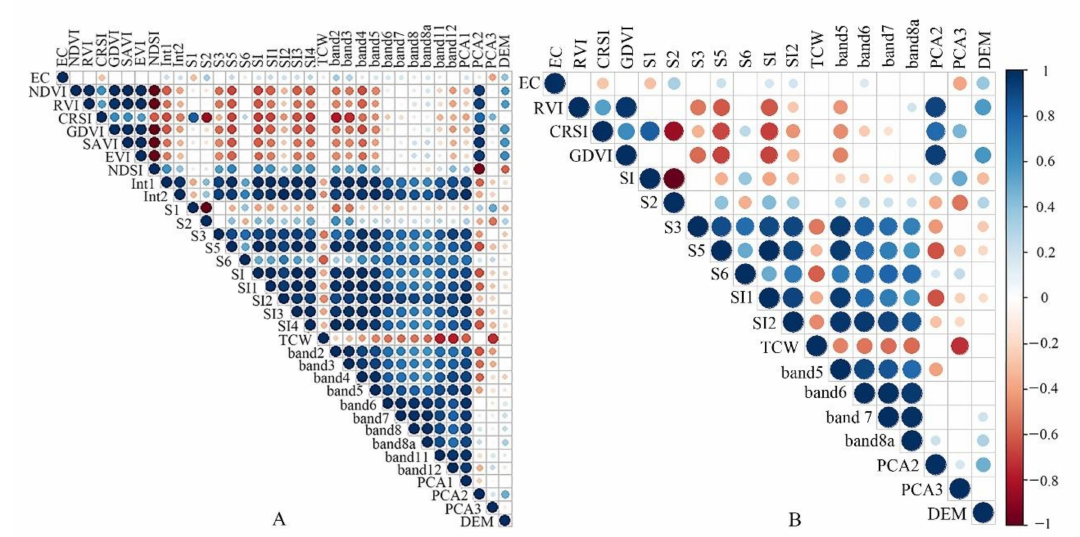
Figure 4. Correlation coefficients between the laboratory-measured soil electrical conductivity (EC) values and Sentinel-2B MSI-derived covariates based on 160 samples. ( A ) Correlogram of all factors; ( B ) correlogram of selected factors.